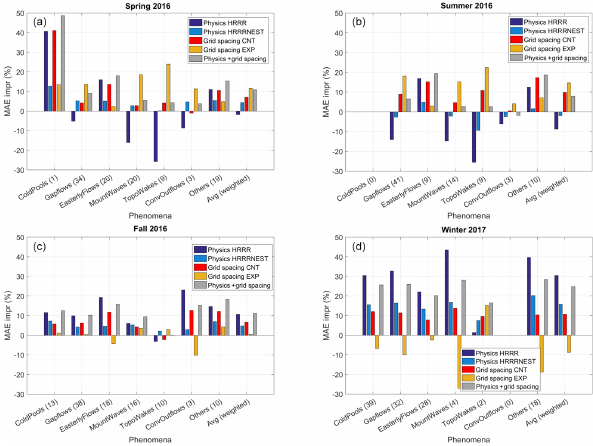
Figure 11. Same as in Fig. 10, but for the four reforecast periods individually (spring, a ; summer, b ; fall, c ; and winter, d